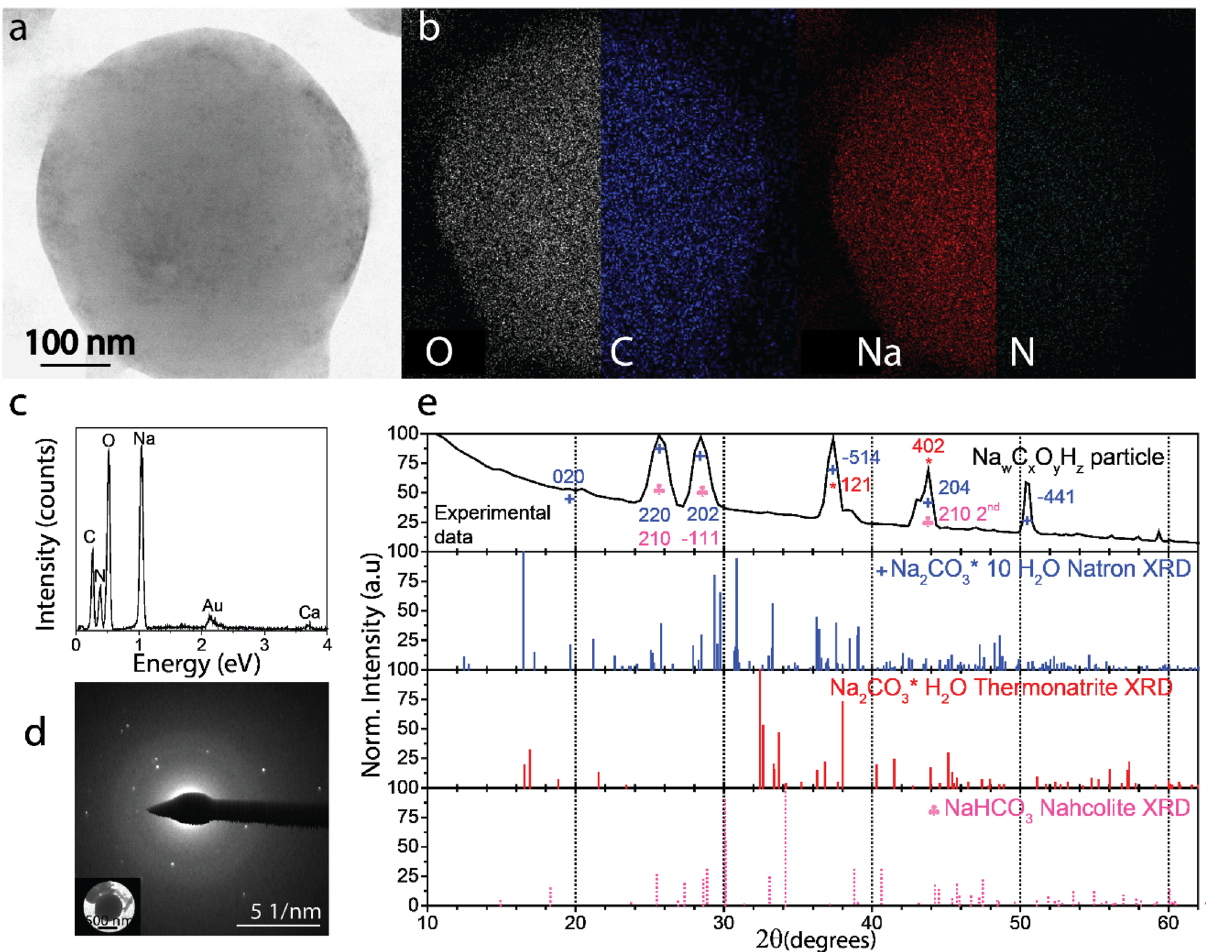
Figure 5. Morphology and chemical composition of isolated, dried carbonate particles in the expelled slime. ( a ) Typical rounded carbonate particle (brightfield STEM). ( b ) Elemental mapping of the particle shown in a. ( c ) SEM energy-dispersive X-ray spectrum of carbonate particle shown in ( d ). Elemental mappings of less abundant elements are presented in Supplementary Fig. 16. ( d ) TEM selected area electron diffraction (SAED) pattern of carbonate particle shown in the insert. ( e ) Crystalline phase analysis based on chemical composition and d-spacings. Note that the reference spectra were calculated from literature X-ray diffraction data of polycrystalline powders. In contrast, the present measurements show the electron diffraction from mostly single crystals for which the peak intensities can in protein composite particles of hundreds of nanometers within secretory vesicles mussel byssus cuticle using STEM-EDS opposite to the velvet worm vesicles that encapsulate mainly inorganic salts 38 . We speculate that this lipid-protein coating could serve for lubrication and help to isolate the particles to avoid the early reaction of inorganic cargo with the outer acidic media. To determine the presence of another type of particle, we also analyzed the supernatant solution. TEM grids of the deposited supernatant solution were analyzed before and after staining with osmium tetroxide and uranyl acetate. Supplementary Fig. 14 shows that lipid particles (without a electron-dense core) and protein aggregates that did not precipitate remained in the supernatant. Detail characterization of the isolated crystalline particles. Elemental mapping of an area with particles showed high relative proportions of O, Na and P and some Ca, Cl and Si. The single, rounded particles mainly contained O, Na and C, while the N signal was barely detectable in the N map (Fig. 5a,b, Supplementary Fig. 15). STEM-EDS elemental analysis of isolated roundish particles (Fig. 5a-c and Supplementary Figs. 15, 17) suggests, based on the elements’ stoichiometry, primarily sodium carbonates (Na: 20 ± 3 at.%; C: 23 ± 7 at.%; O: 41 ± 9 at.%). The micrometer-sized rounded particles shown in Fig. 5a presented crystalline reflections in the reciprocal space (Fig. 5d) with d-spacings of 3.19 Å, 2.82 Å, 2.00 Å, 1.62 Å, and 1.27 Å, corresponding to the (220), (202), (− 514), (204), (− 441) crystal planes of monoclinic natron (Na 2 CO 3 ·10H 2 O 39,40 ) with a matching accuracy of 99.28–99.96% (Fig. 5e, Supplementary Fig. 17 and Table 2). The sodium carbonate particles were preferentially round in shape, but other more angular morphologies were found occasionally within the isolated pellet. It was interesting to note that these carbonate microparticles were highly reactive. Under the electron